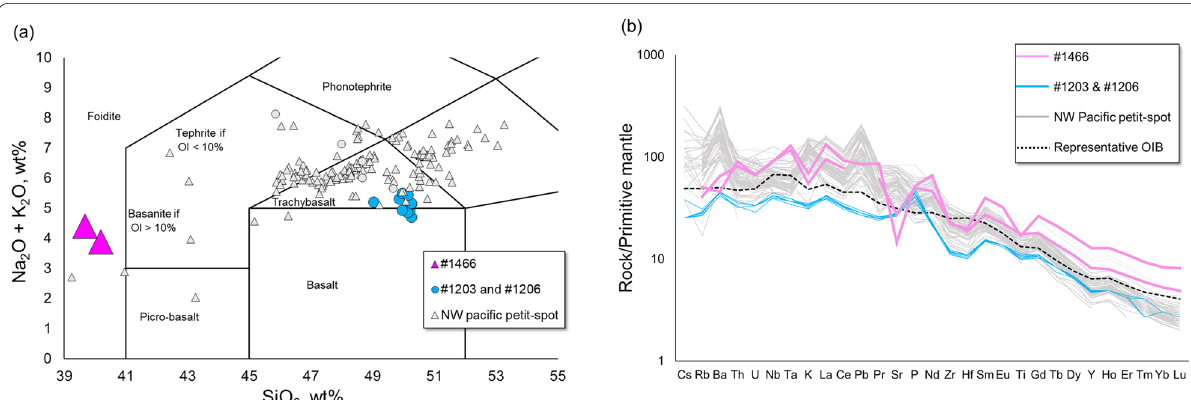
Fig. 4 Geochemistry of the petit-spot basalts. a Total alkali silica diagram. Triangles and circles show the whole-rock and quenched glass compositions, respectively. The whole-rock composition of 6K#1466 basalts (pink triangles) is highly silica-undersaturated. The compositions previously reported at petit-spots from the NW Pacific are represented as open triangles and circles (Hirano et al. 2006; Machida et al. 2015; Sato et al. 2018). b Primitive mantle normalized trace-element compositions of basalts. The pink lines are 6K#1466 basalts in this study, and the blue lines are those reported by Hirano et al. (2019). The gray lines describe previously reported petit-spots from the NW Pacific (Hirano et al. 2006; Machida et al. 2015; Sato et al. 2018). Dotted lines describe the values of representative OIBs (Oceanic Island Basalts) and primitive mantle, from Sun and McDonough (1989). The numerical data are provided in Table